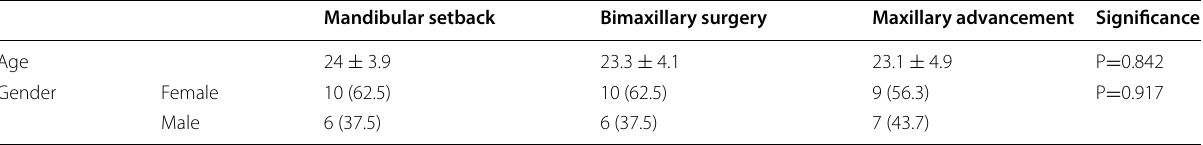
The Age has been shown by mean